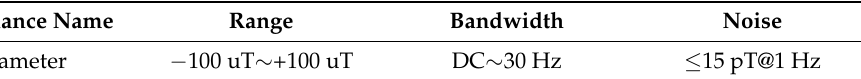
Table 1. The performance parameters of the fluxgate.